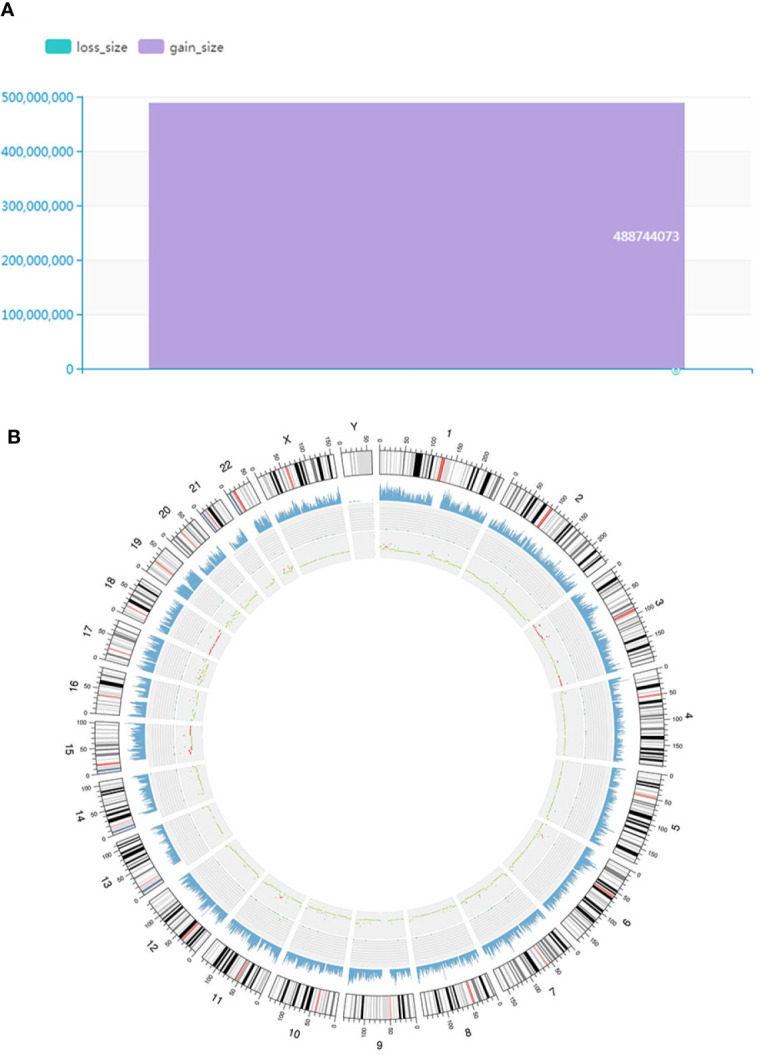
Findings of somatic CNVs distribution and genomic variation analysis. (A) Distribution of somatic CNVs. The ordinate represents the total length (mb) of the copy number increase (gain_size) and copy number decrease (loss_size). Furthermore, the abscissa indicates different samples. (B) Genomic variation Circos display. The three-layer structure from the outside to the inside represents the sequencing coverage map, the density of SNPs and INDELs and the CNV results, respectively. Red indicates an increased copy number, blue indicates a missing copy number, and green indicates a normal copy number.